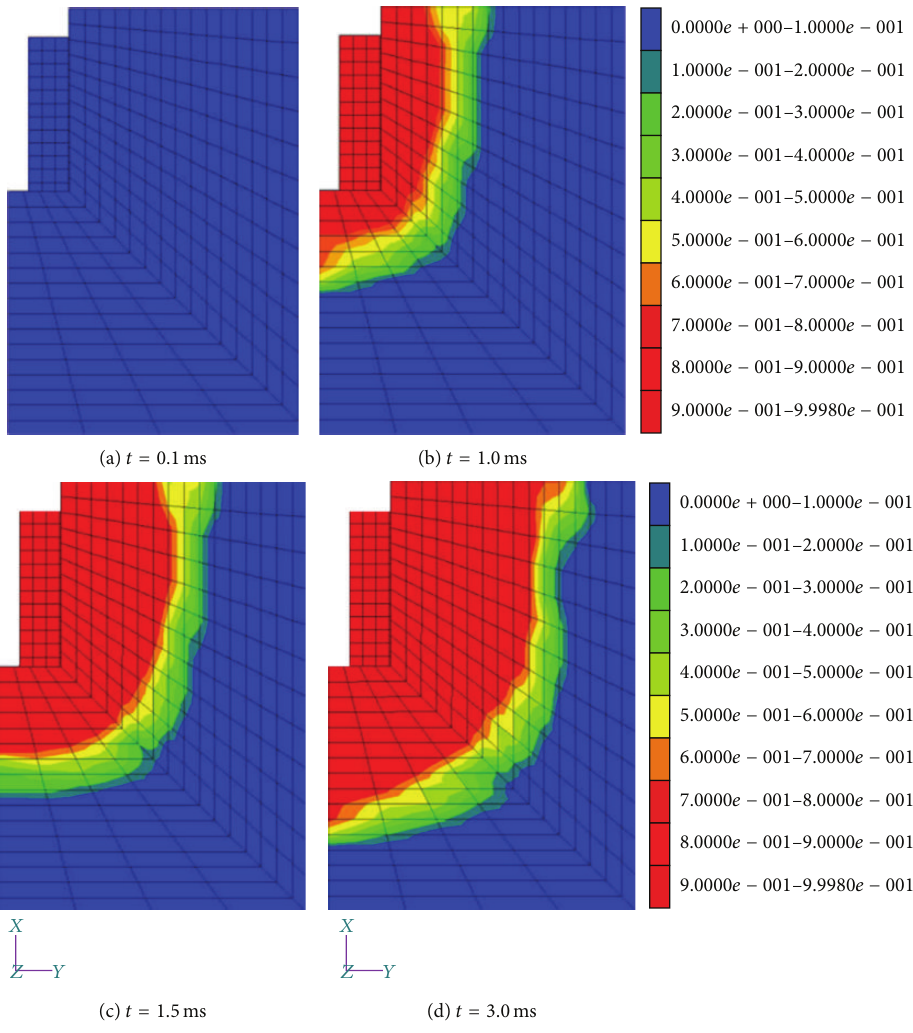
Figure 6: Damage growth on the bottom free